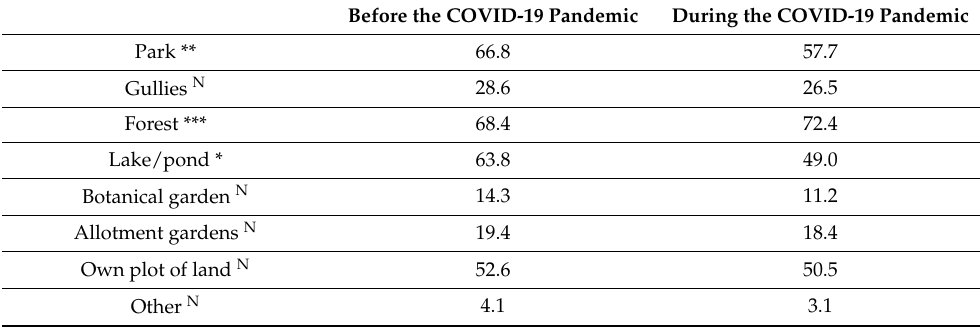
Table 4. Types of recreation areas chosen for leisure activity (%). Before the COVID-19